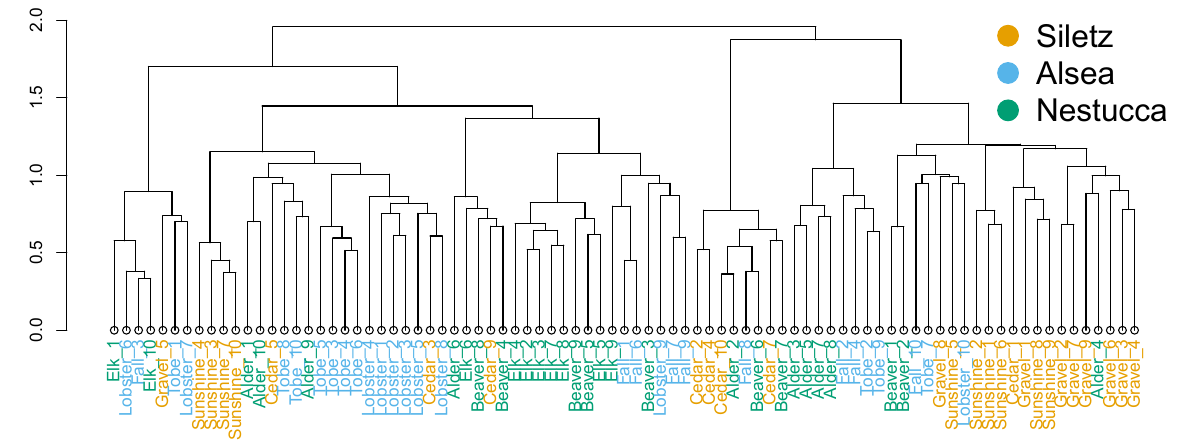
Figure 2. Steelhead gut microbiome samples from three different river basins in Oregon roughly group together. Dendrogram showing hierarchal clustering (Ward’s method with Ward’s clustering criterion) comparing Bray–Curtis dissimilarities between samples. Samples are colored by river basin origin. Samples do not neatly separate into three groups, but the samples tend to cluster into smaller groups with like colors. The differences between steelhead gut microbial composition are confirmed statistically (PERMANOVA, R 2 = 0.05, p < 0.01).